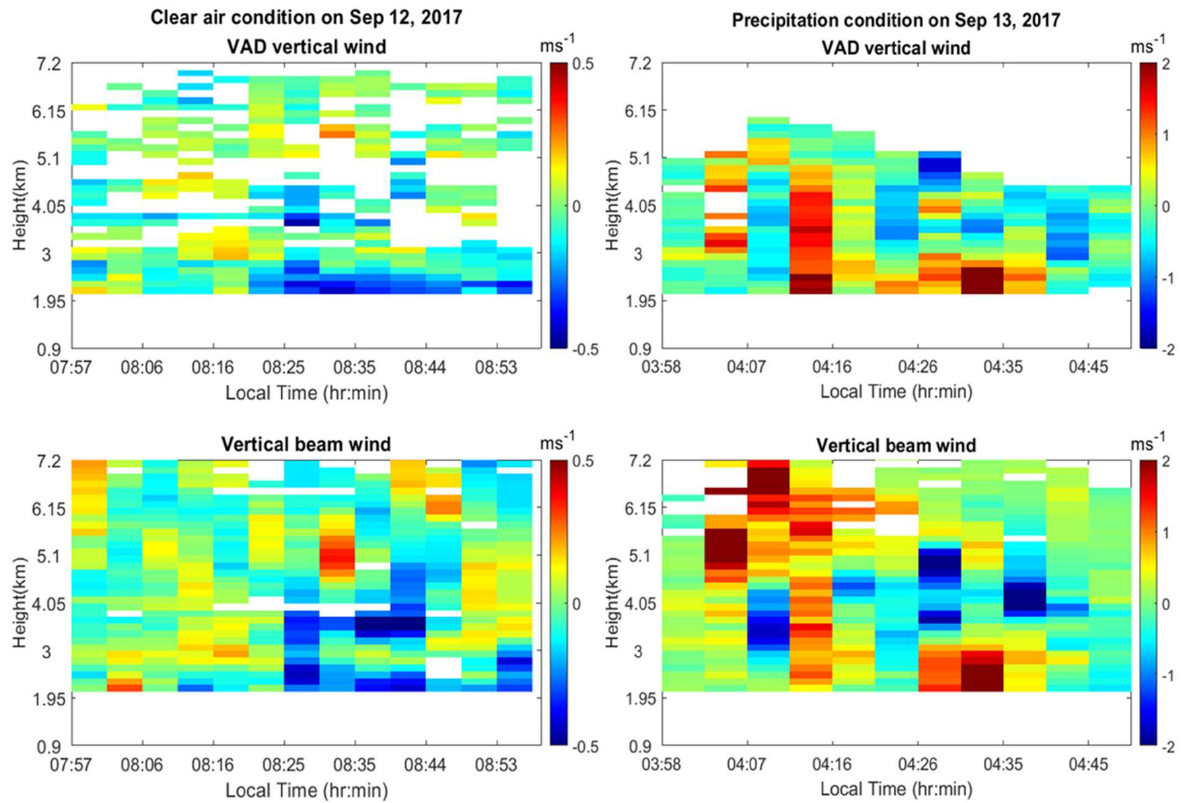
Figure 15. Vertical wind velocities estimated by VAD method ( upper panels) and observed by vertically pointed beam ( bottom panels) of 52 MHz Chung-Li VHF radar for clear air ( left panels) and precipitation ( right panels) environments.